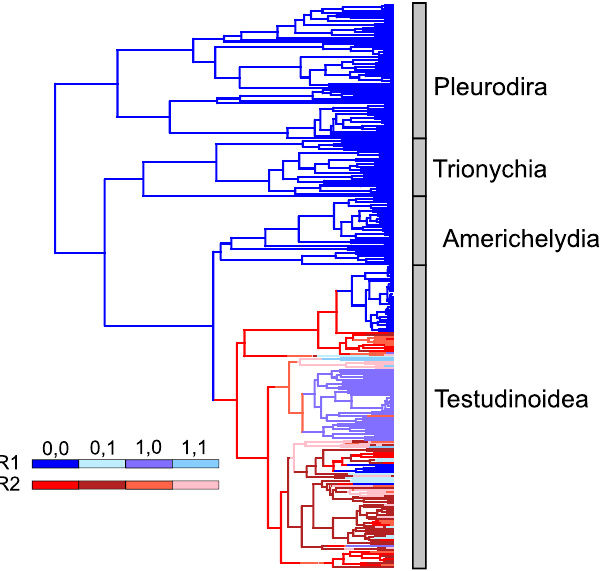
Figure 5. Character history for macrohabitat (aquatic/terrestrial) and mental gland occurrence (present/ absent) in chelonians according to a generalized hidden Markov process with two equal rate (ER) transition matrices (ER/ER model). Branches colored in different shades of blue and red represent state combinations of the two traits evolving according to two different transition matrices (R1, R2, shown in the legend). The tree shows that the underlying evolutionary process in Testudinoidea is distinct (evolves along a different transition matrix) in relation to most other clades of turtles and tortoises. 0,0—aquatic, gland absent; 0,1—aquatic, gland present; 1,0—terrestrial, gland absent; 1,1—terrestrial, gland